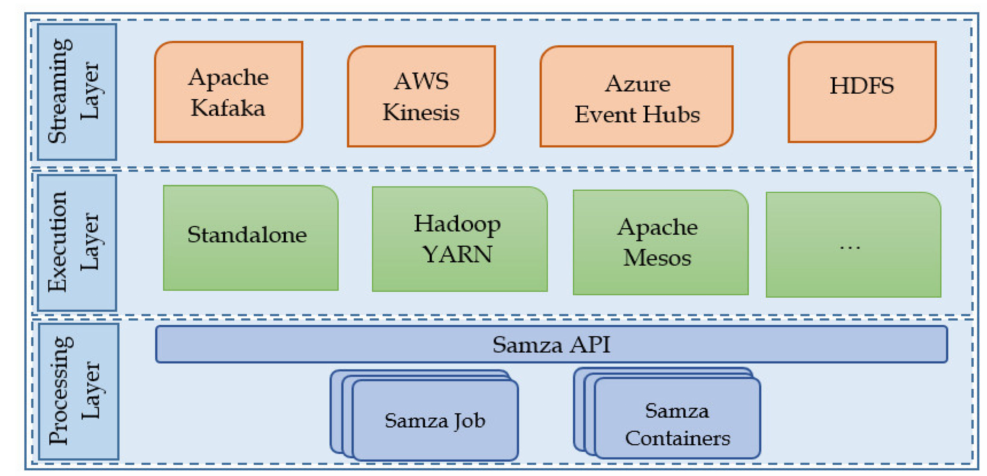
Figure 8. The layered architecture of